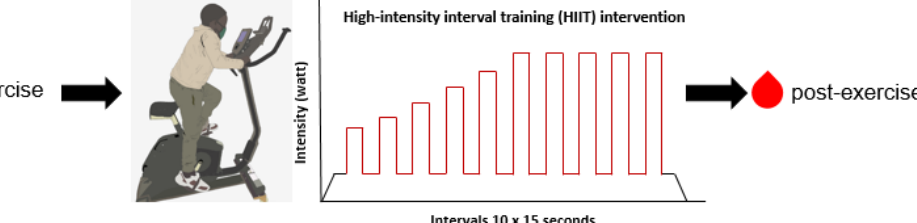
Figure 1. High-intensity interval training (HIIT) intervention protocol, including point of time for blood samples.